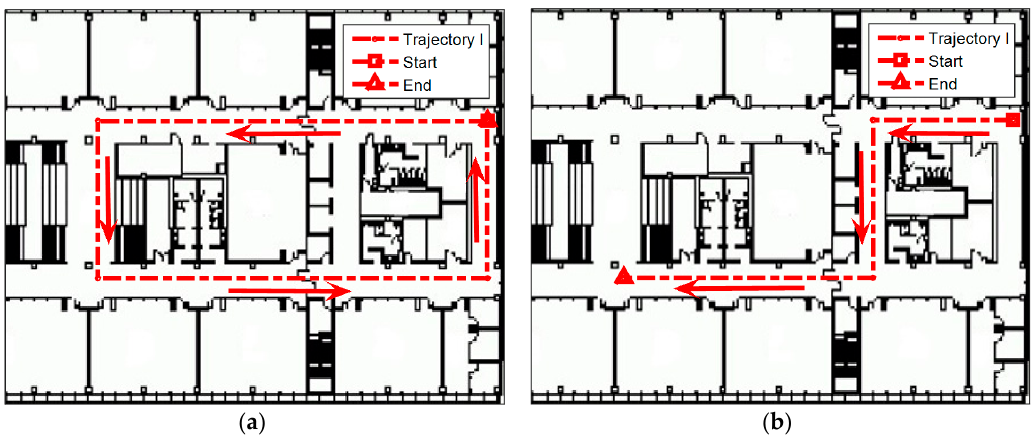
Figure 10. Two trajectories for performance evaluation: ( a ) Trajectory I; and ( b ) Trajectory II.